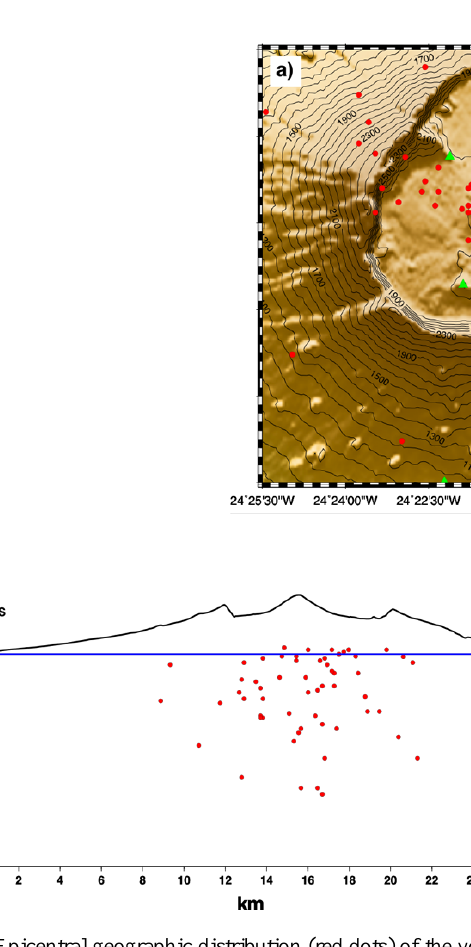
Fig. 9. (a) Epicentral geographic distribution (red dots) of the volcano-tectonic events recorded on Fogo between September 2011 and May 2013 (contour lines are in metres a.s.l., and green triangles represent the seismic stations). (c) Hypocentres projected on a section parallel to the S–N direction. (d) Hypocentres projected on a section parallel to the W–E